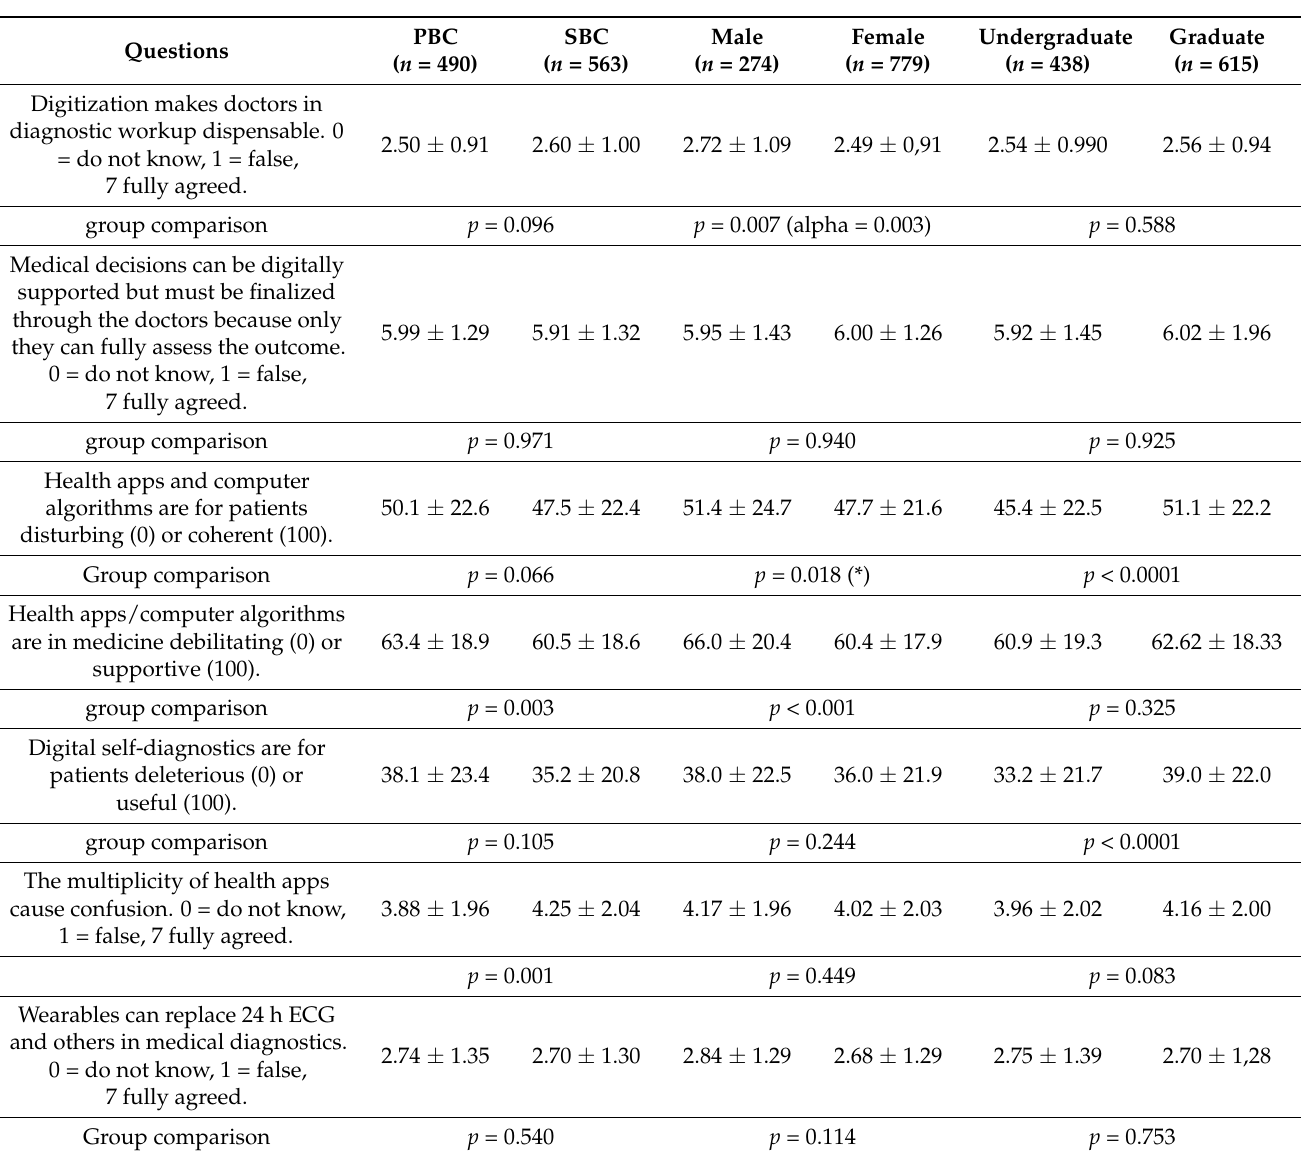
Table 3. Response (sum ± STD) from Likert scale responses to given questions. Statistical group comparison using the unpaired, two-tailed Wilcoxon rank-sum